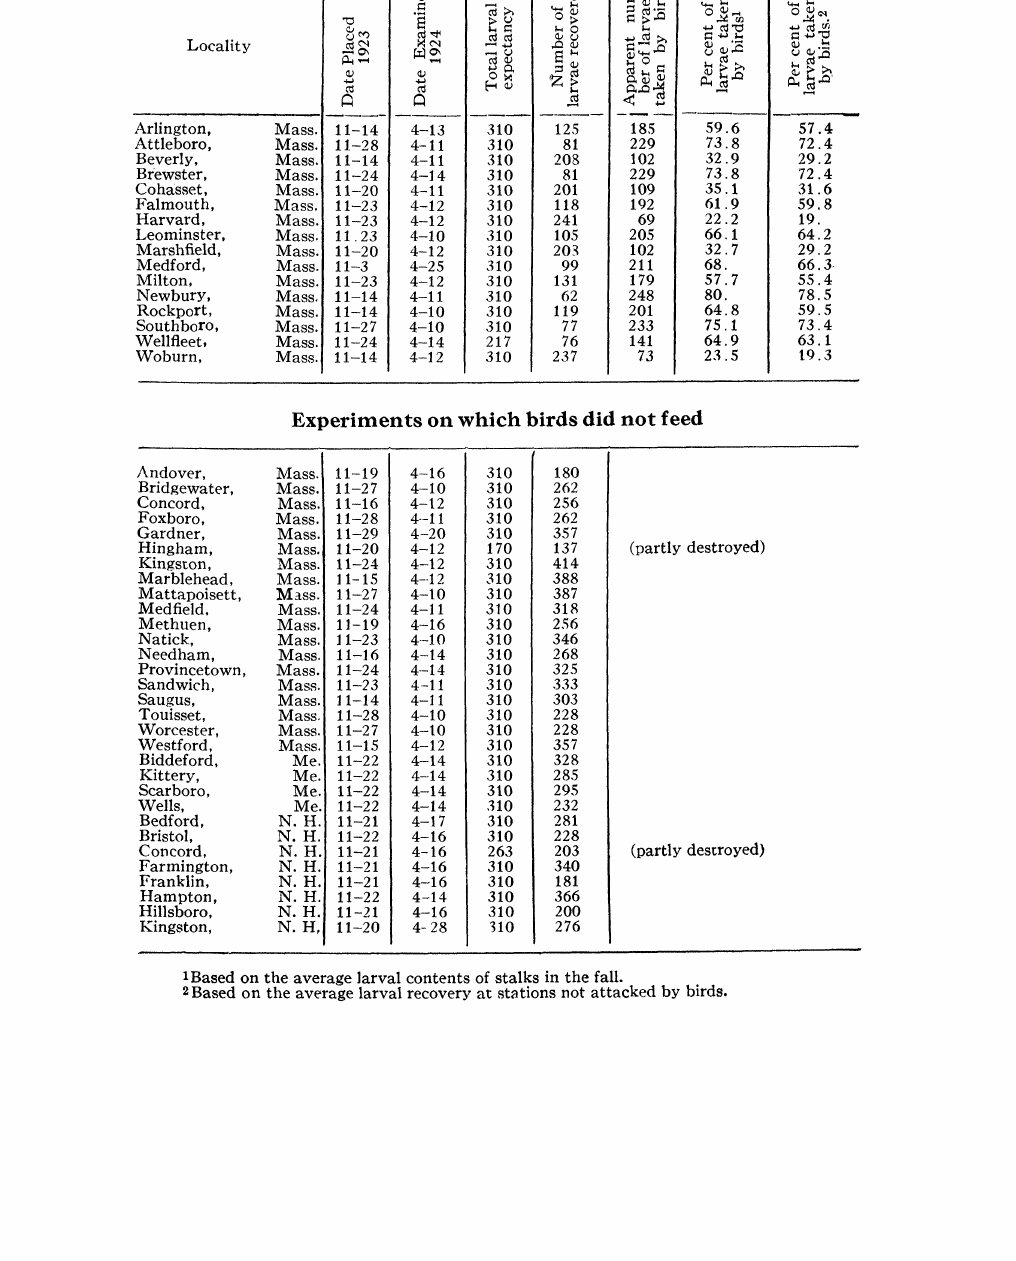
Extent of Feeding by Birds on Experimental Material in the Spring of 1924. Experiments on which birds